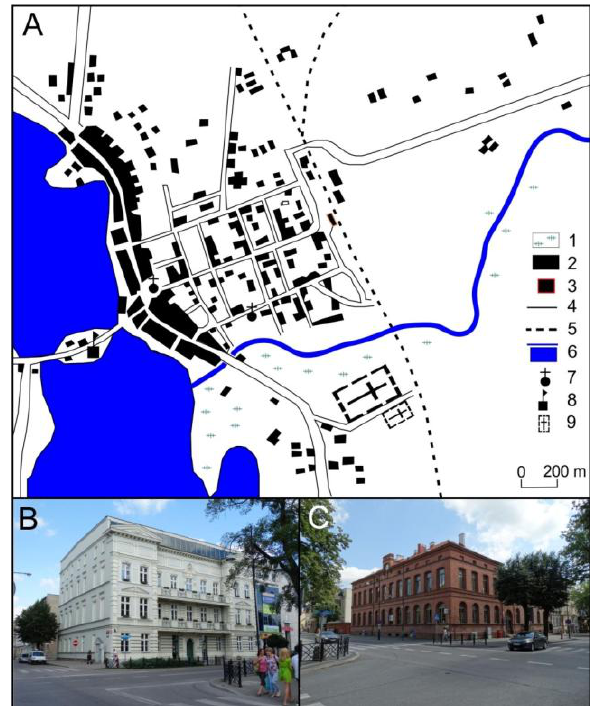
Fig. 3. Spatial layout of Ełk ( Lyck ) in the 1930s (A), tenement house in the present day Armii Krajowej Street (formerly Bahnhofstraβe ) (B) and post office (C) (Source: author’s own study based on Topographische Karte…, 1937 (A); photo by author (B-C)